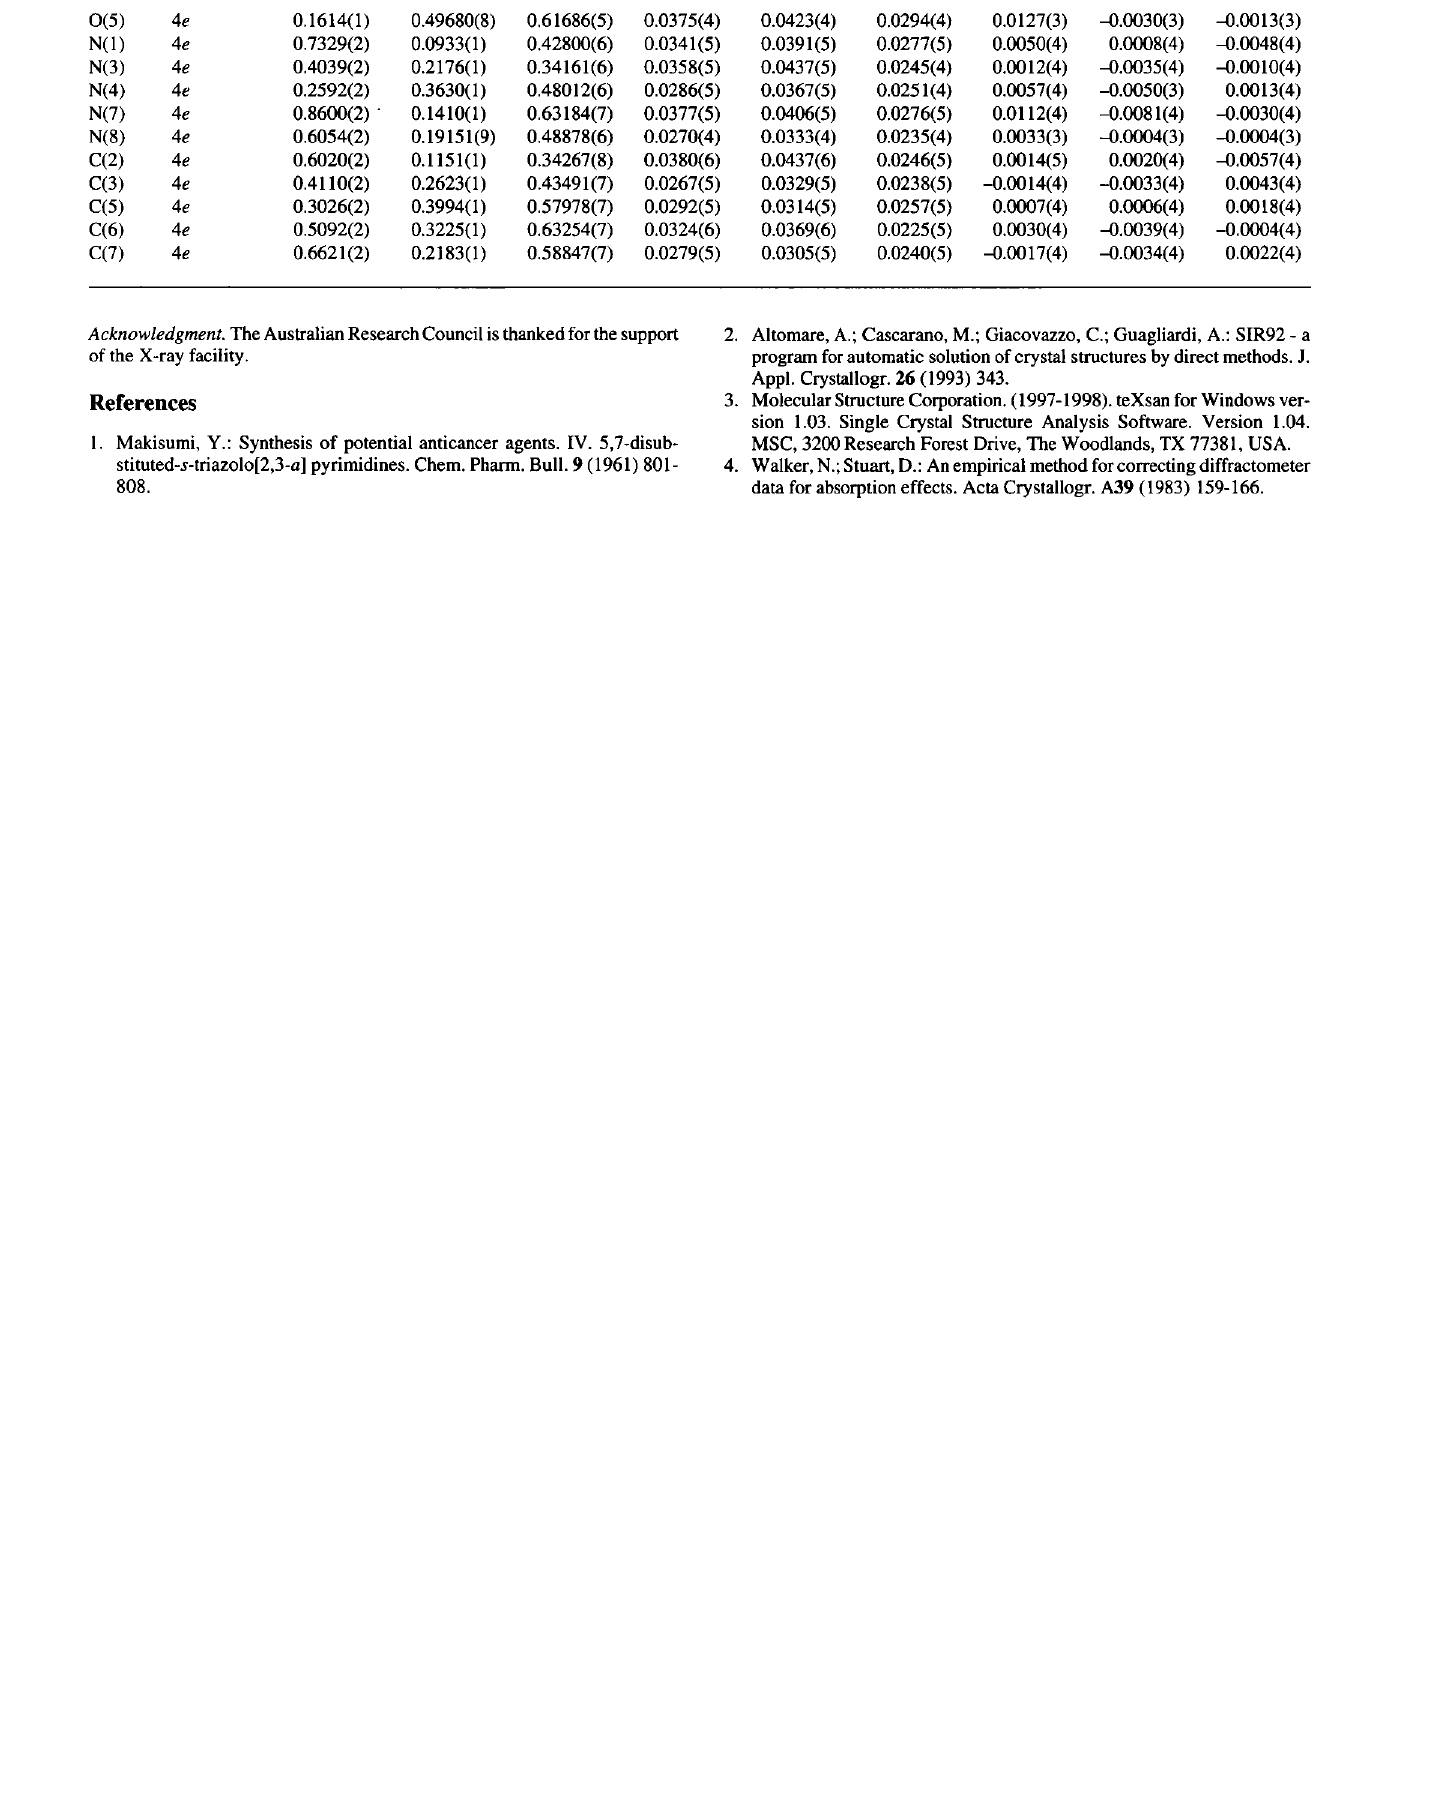
Table 3. Atomic coordinates and displacement parameters (in Ä 2